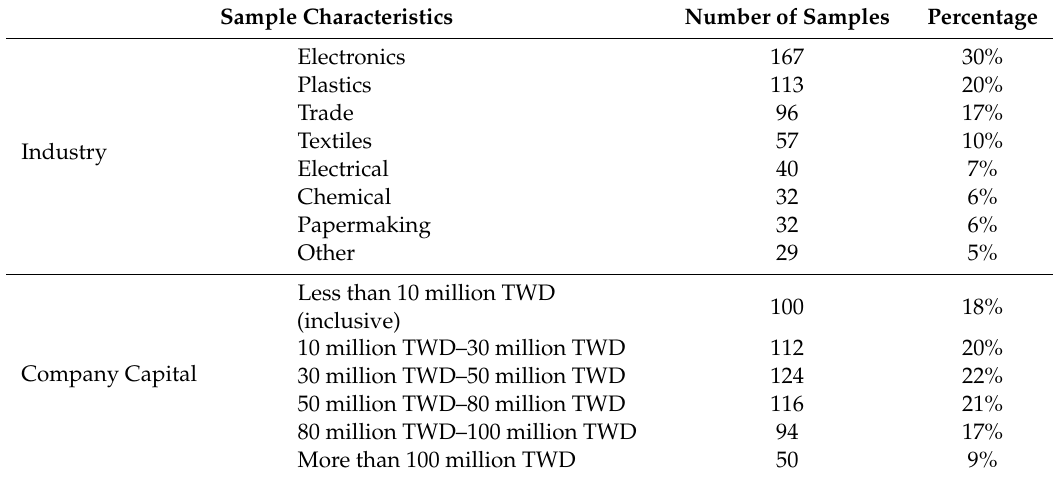
Table 2. Demographic characteristics of